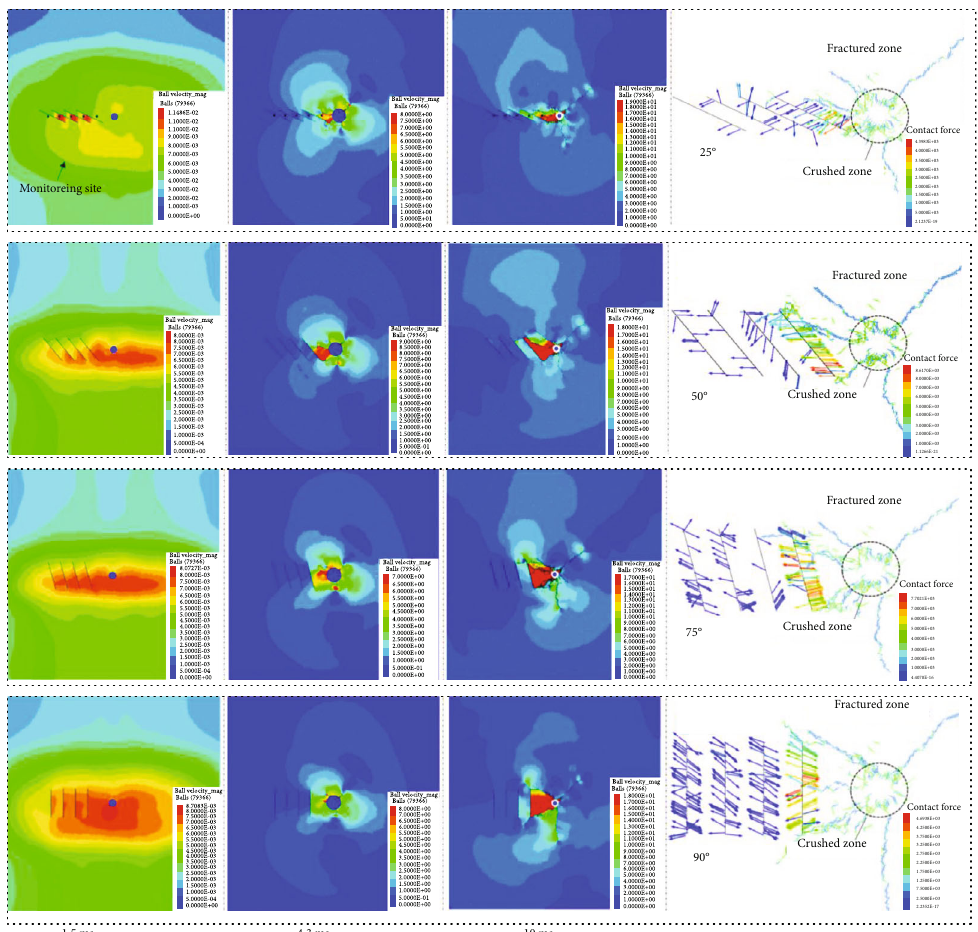
Figure 11: Evolution characteristics of explosion crack morphology of multiple joint rock mass.